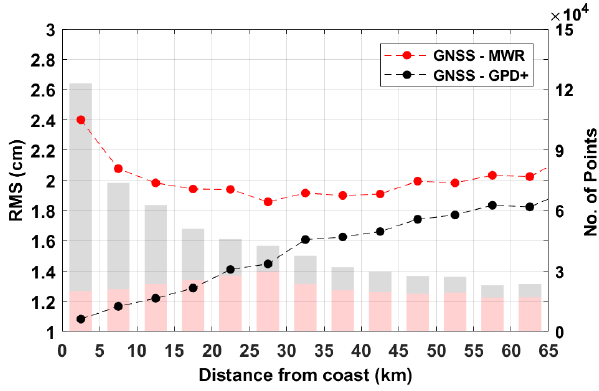
Figure 10. RMS (in cm) of WTC differences (left axis) and number of altimetry measurements used (right axis) for the Envisat mission, as a function of distance from the coast. Red bars represent the num- ber of measurements used to compute the RMS of the differences GNSS − MWR, while grey bars represent the number of points used to compute the RMS of the differences GNSS − GPD + . In the com- parison GNSS − MWR only valid MWR-derived observations have been